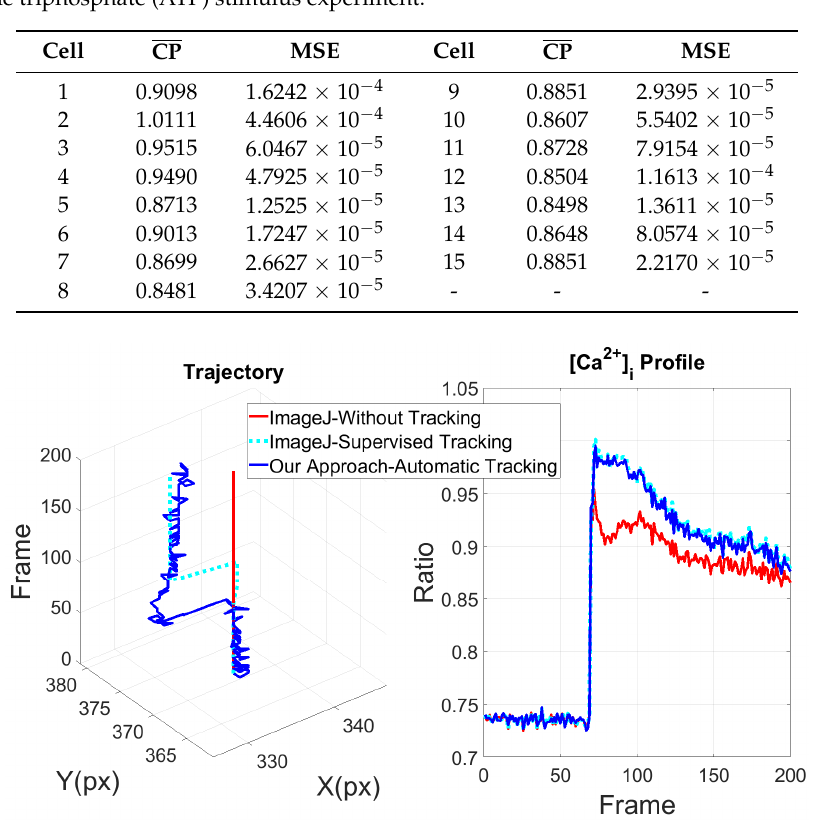
Figure 2. ( Left ), shows the cell trajectory, cell position in X and Y axes respectively, measured in pixels (px) and compared between ImageJ without tracking (red line), ImageJ with manually tracking (cyan line) and trajectory obtained with our automated tracking proposed system (blue line); ( Right ), shows an example of CPs calculated in each condition previously described.